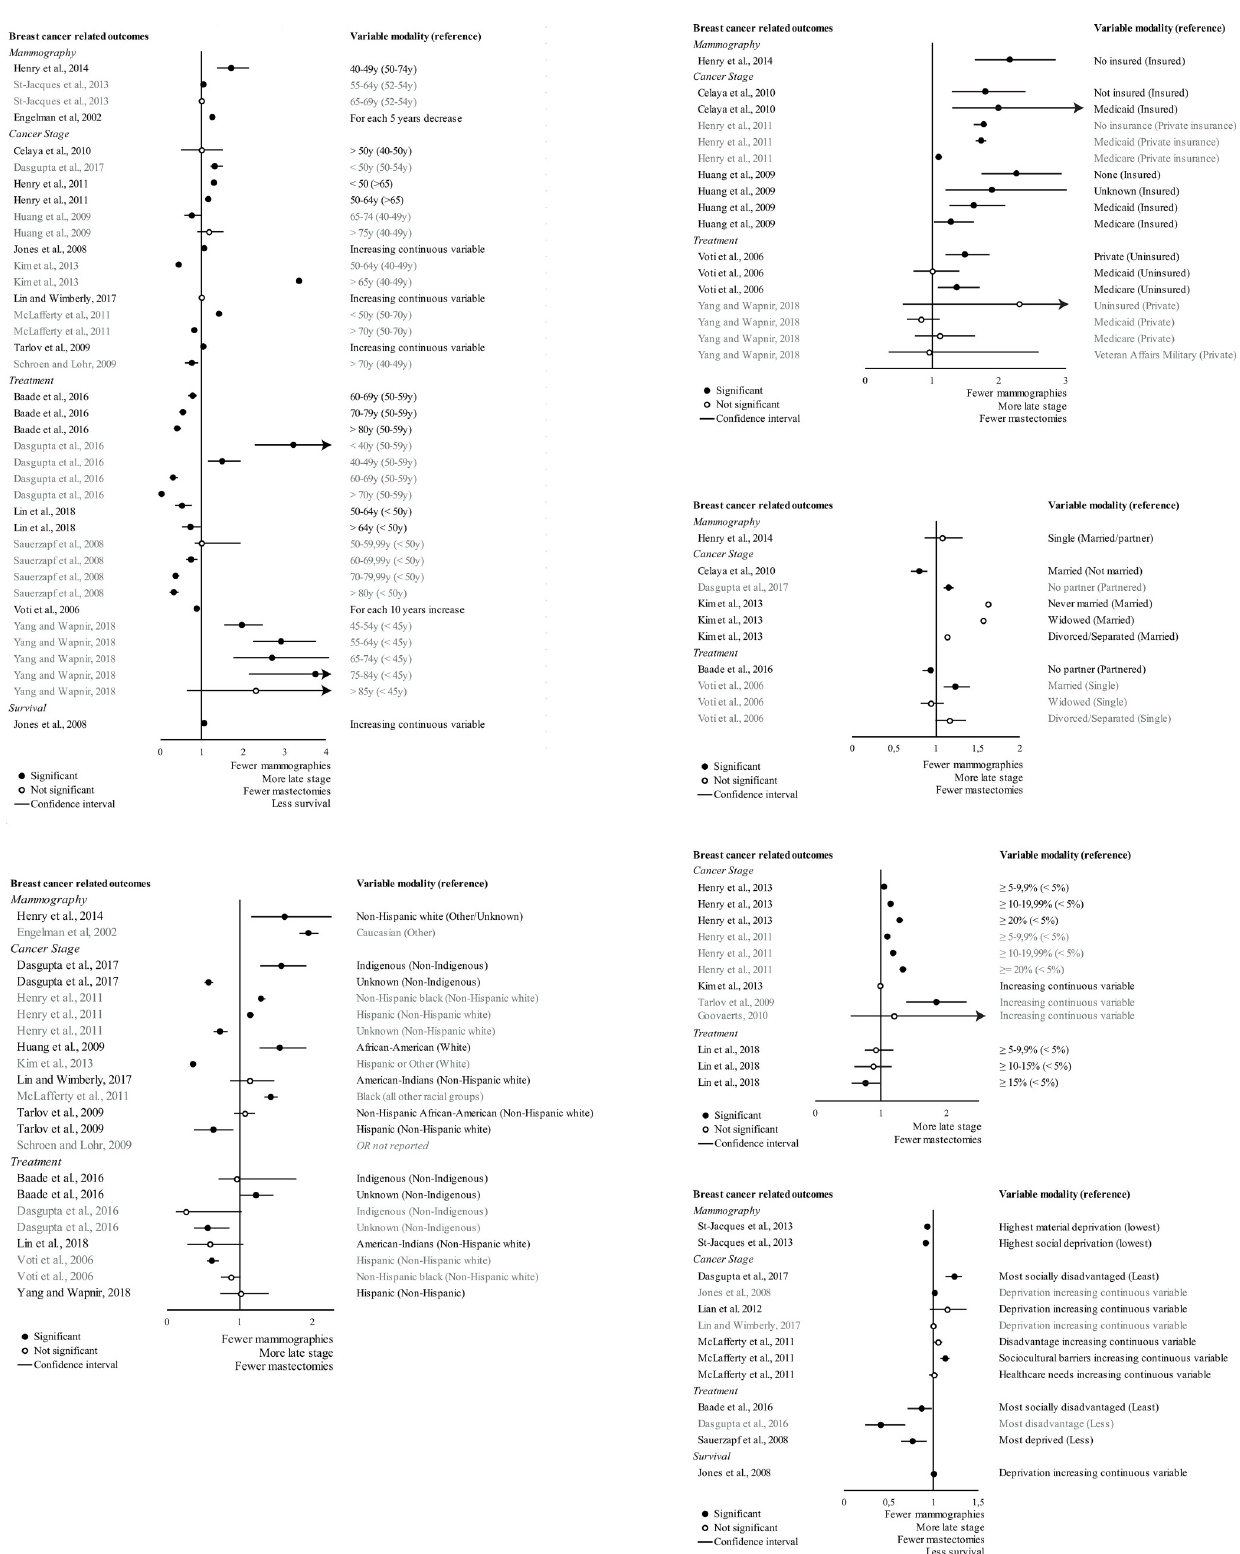
Fig 2. Forest plot showing the relationship between SES characteristics (at the individual and contextual levels) and breast cancer outcomes. a) Age, b) Ethnicity, c) Insurance status, d) Marital status, e) Poverty rate at residential level, f) Deprivation index at residential level. https://doi.org/10.1371/journal.pone.0271319.g002 PLOS ONE | https://doi.org/10.1371/journal.pone.0271319 July 19,